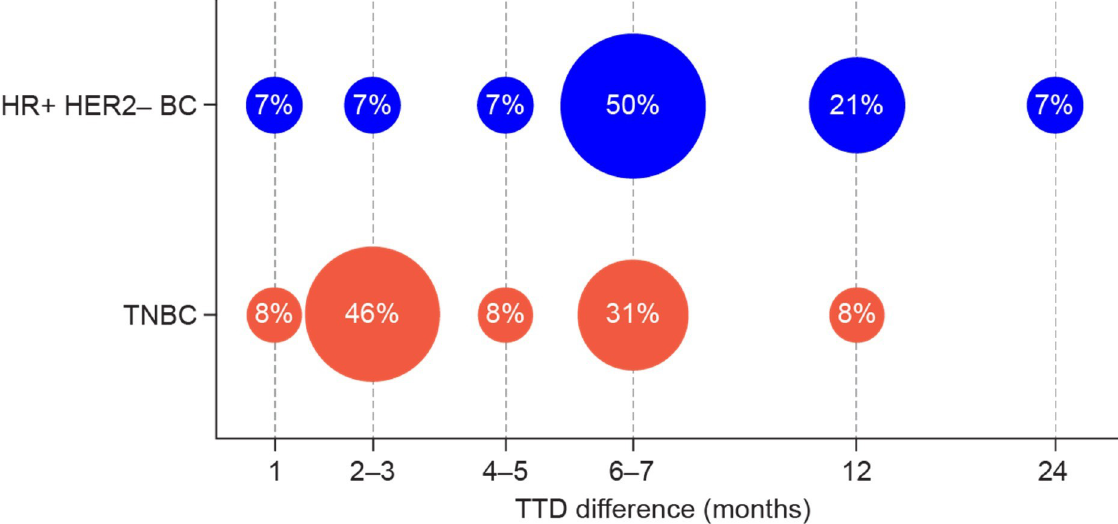
Fig 3. Minimum meaningful TTD difference in physical functioning by breast cancer sub-type.